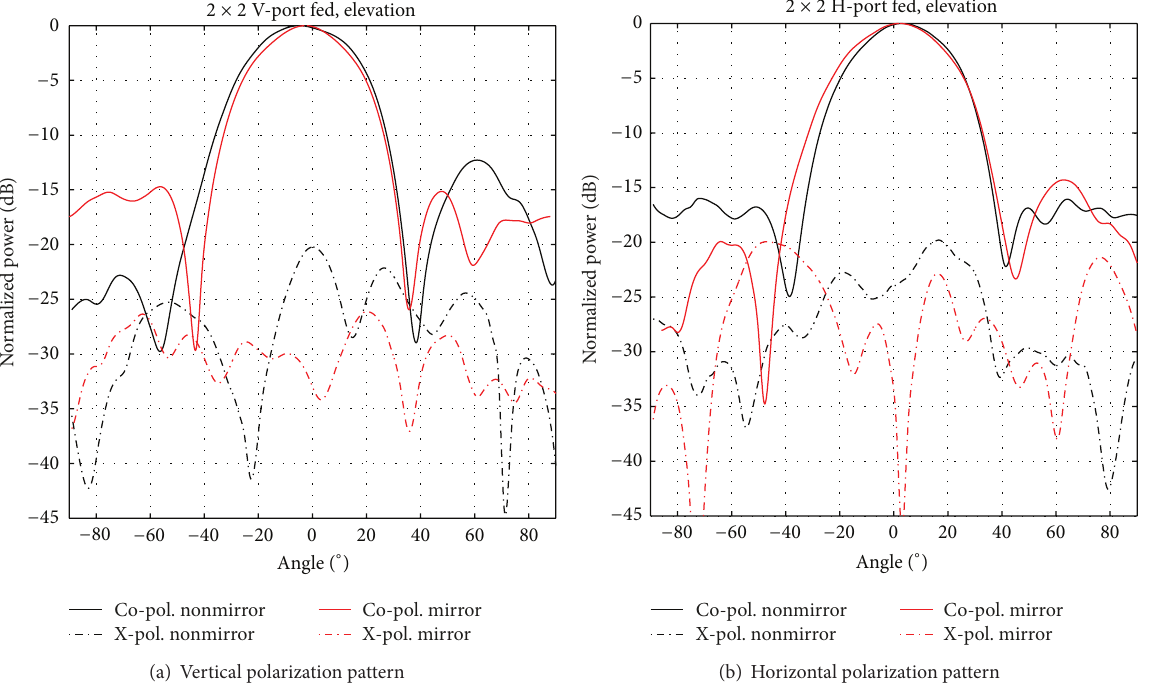
Figure 13: Measured radiation patterns for the 2 × 2